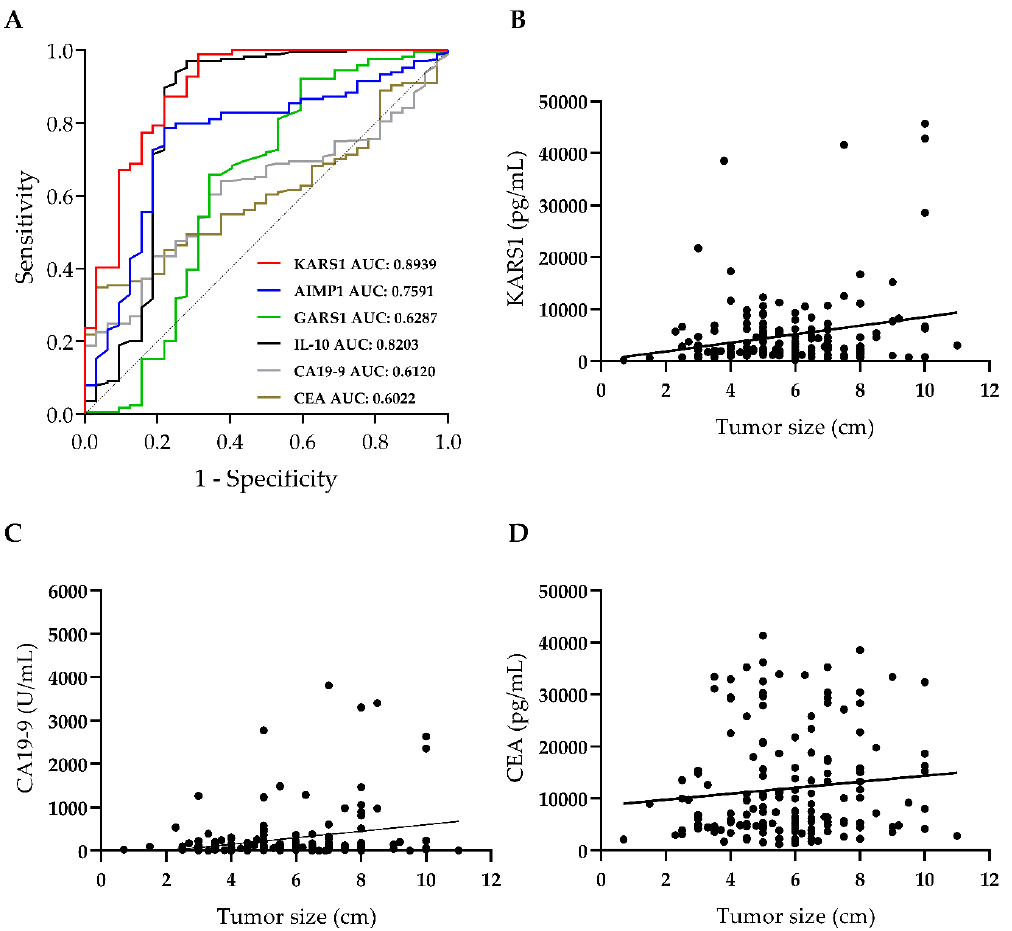
Figure 2. Diagnostic values of plasma KARS1 in CRC patients . Receiver operating characteristics (ROC) curves for Aminoacyl tRNA Synthetases (ARSs) and cancer biomarkers were analyzed. ROC curves of plasma KARS1, AIMP1, GARS1, IL-10, CA 19-9, and CEA ( A ) were used to differentiate CRC patients from healthy controls. Correlation of CRC plasma levels of proteins, including KARS1 ( B ), CA 19-9 ( C ), and CEA ( D ), with tumor size analyzed using Pearson correlation coefficient; AUC: Area under ROC curve.